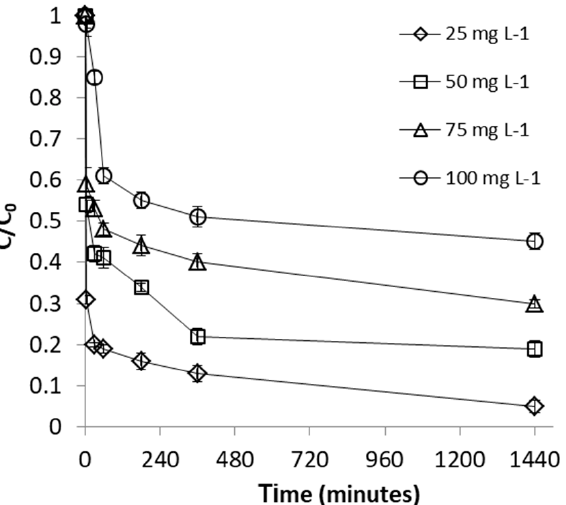
Figure 3. Effect of initial concentration on Fe II removal by WSP. The lines are not fitting models; they simply connect points to facilitate visualization.